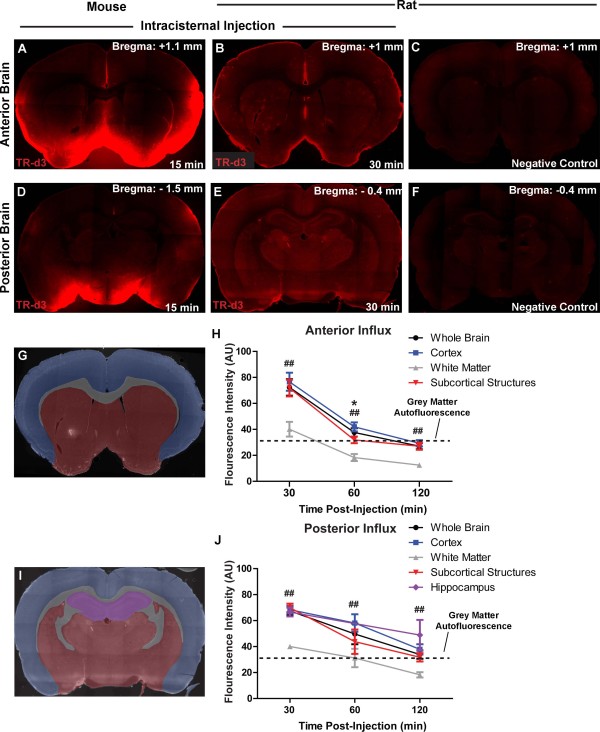
Evaluating intracisternal CSF tracer influx and clearance in mouse and rat. Representative anterior (A-B) and posterior (D-E) coronal slices from mouse (A, D) and rat (B, E) brains following intracisternal infusion of Texas Red-conjugated dextran (TR-d3, MW 3kD; t = 30min post-infusion) show similar tracer distributions between species. (C, F) Un-infused rat brain slices exhibit little tissue autofluorescence. (G-J) Tissue fluorescence was evaluated in different brain regions: cortex (blue), white matter (grey), hippocampus (magenta), and subcortical structures (red) of the anterior (G-H) and posterior (I-J) brain. (H, J) Quantification of mean fluorescence intensity within each region (*P < 0.05 cortex vs. subcortical structures; ##P < 0.01 cortex vs. white matter structures; 2-way ANOVA; n = 3–4 per time point). Dashed line indicates average gray matter tissue autofluorescence level.